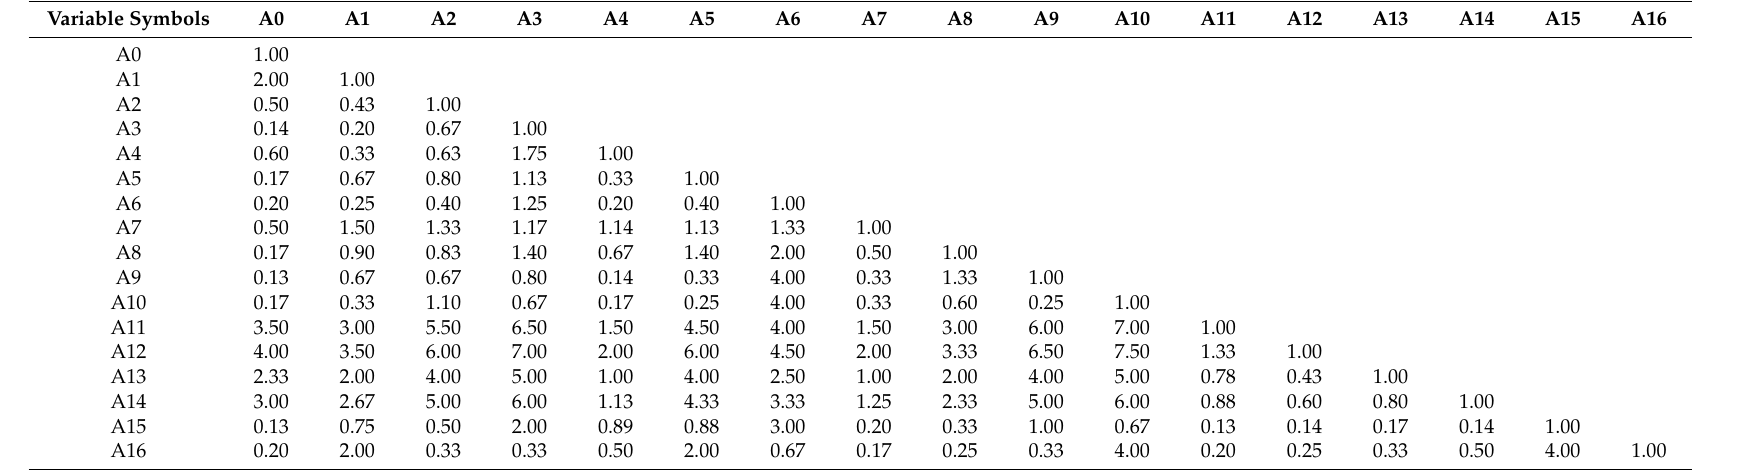
Table 2. Pairwise comparison matrix and the normalized relative importance weight vector for the irrigation salinity risk assessment and mapping in the Keriya Oasis. Variable